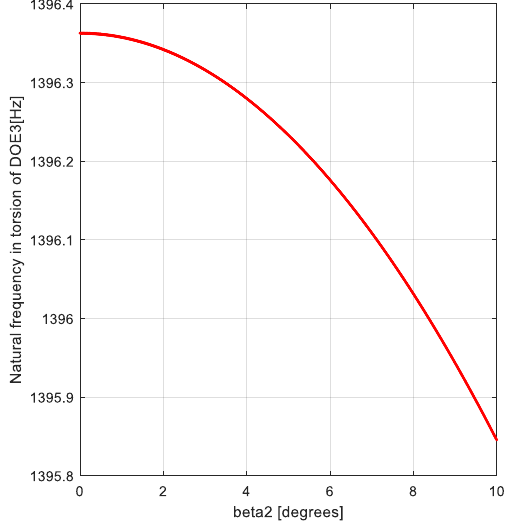
Figure 10. Variation of Ω 3 ( β 2 ) for DOE3. Figure 10. Variation of ( )   for DOE3. 3 2